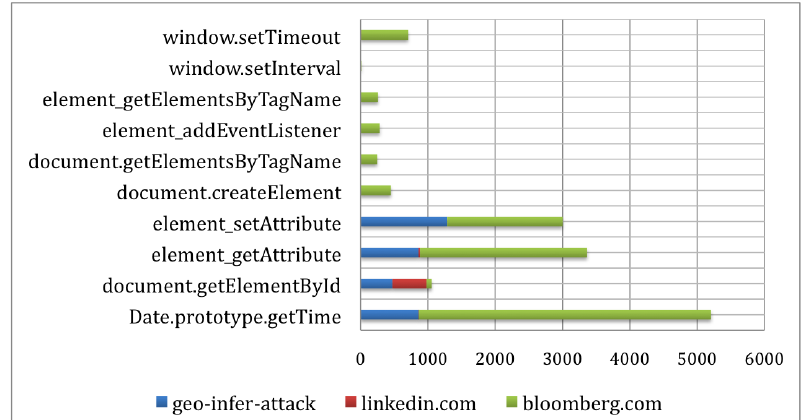
Figure 1. Distribution of the essential function calls.